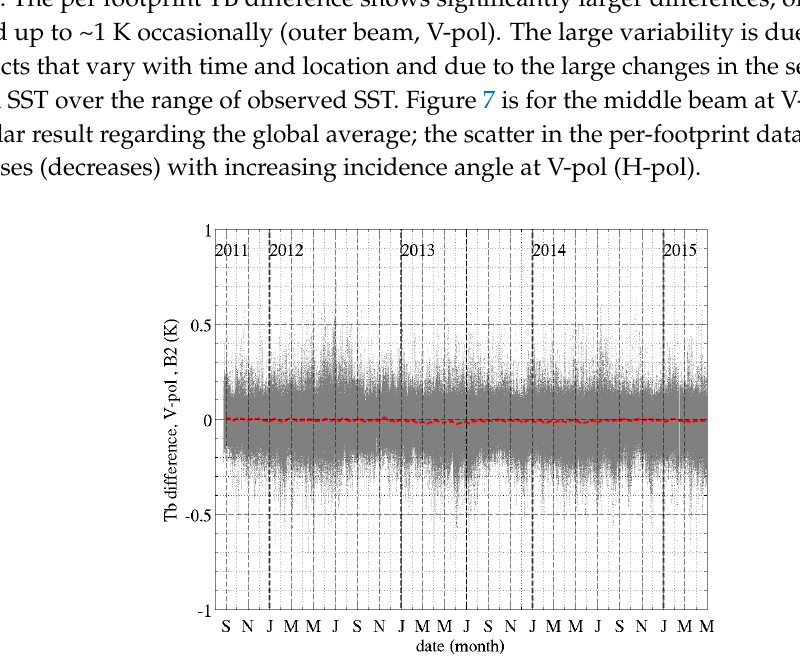
( c ) Figure 6. Impact of SST differences on TB and retrieved SSS. ( a ) Map of SST differences (°C) between OSTIA and NOAA OI interpolated at the Aquarius ground tracks (same week as in ( b ) in Figure 5, ascending orbits). ( b ) Differences in TB (K) for a flat surface due to the differences in SST in the left figure. ( c ) Differences in retrieved SSS (psu) due to differences in TB reported in the middle figure. The impact of SST differences on the SSS retrievals will depend on 1) the sensitivity of TB to SST